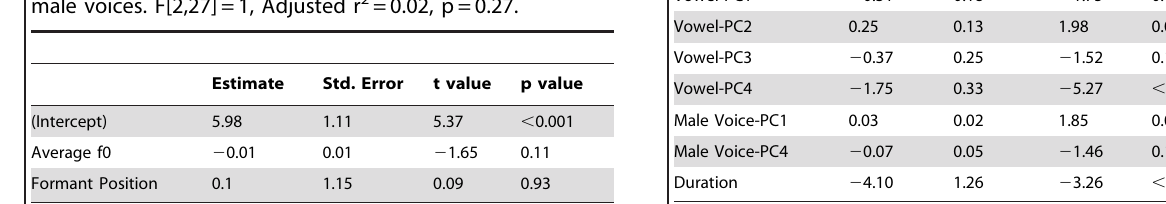
Table 8. Predictors for the traditional regression model with